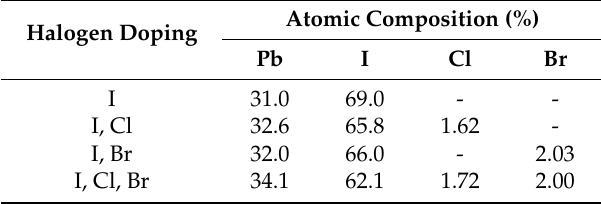
Table 5. Atomic composition of halogen atom of the CH 3 NH 3 PbI 3 ´ x ´ y Br x Cl y perovskite solar